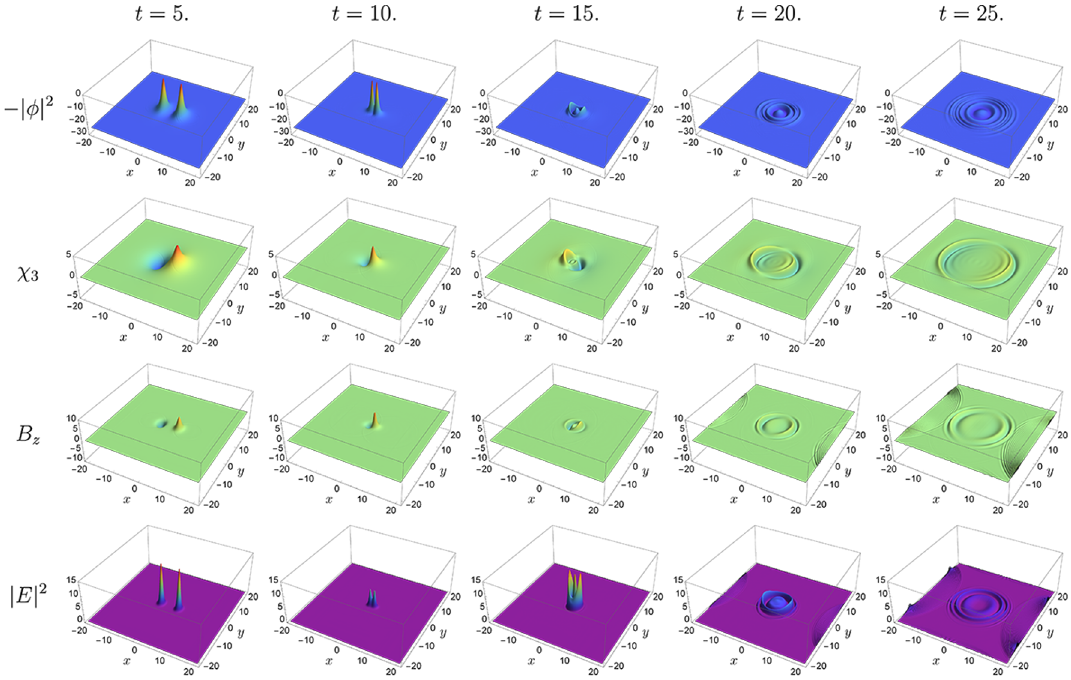
Figure 38 . Snapshots of −| φ | 2 , χ 3 , B z and | E | 2 for the head-on scattering of a type I* anti-parallel vortex-antivortex state with initial velocity u = 0 . 7 . Note the vortices annihilate during the collision occurring around t = 11 . 5 , and only waves are present thereafter.